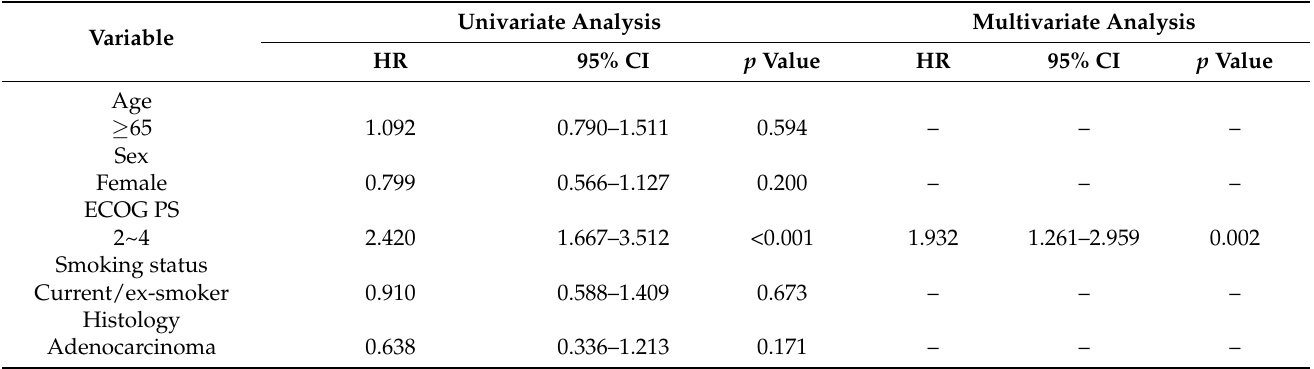
Figure 4. Denosumab effect on OS in EGFR -mutated NSCLC patients with bone metastasis with or without denosumab therapy. CI: confidence interval; EGFR : epidermal growth factor receptor; NSCLC: non-small cell lung cancer; OS: overall survival. Table 3. Cox regression analysis of overall survival of EGFR -mutated NSCLC patients with bone